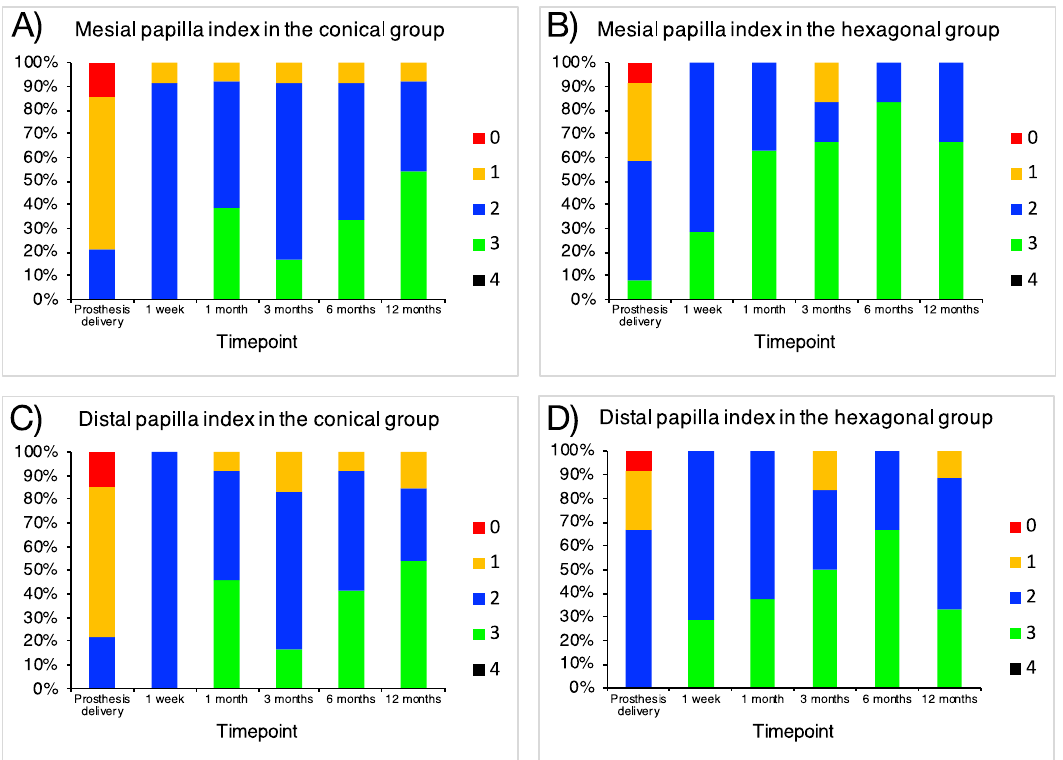
Figure 4. Percentages of each papilla index at the different timepoints at ( A , B ) mesial and ( C , D ) distal sites of ( A , C ) conical and ( B , D ) hexagonal-connection implants; 0 = no papilla; 1 ≤ 50% filling of the interproximal area; 2 ≥ 50% filling; 3 = ideal papilla; 4 = overgrowth.